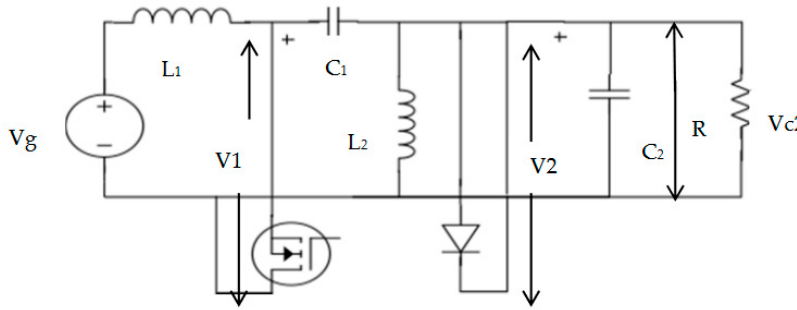
Figure 7. Switches separated.